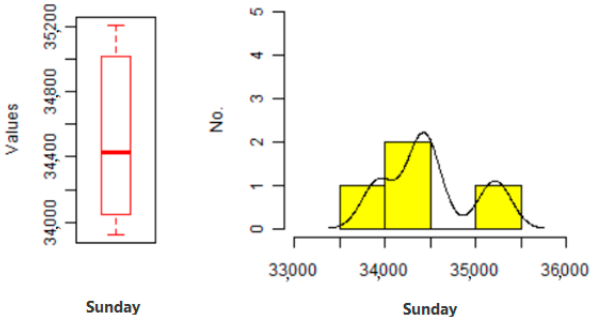
Figure 13. After the variance of excluding the noise data on Sunday: In the graph, the vertical axis is the day of the week, and the horizontal axis is the traffic volume.